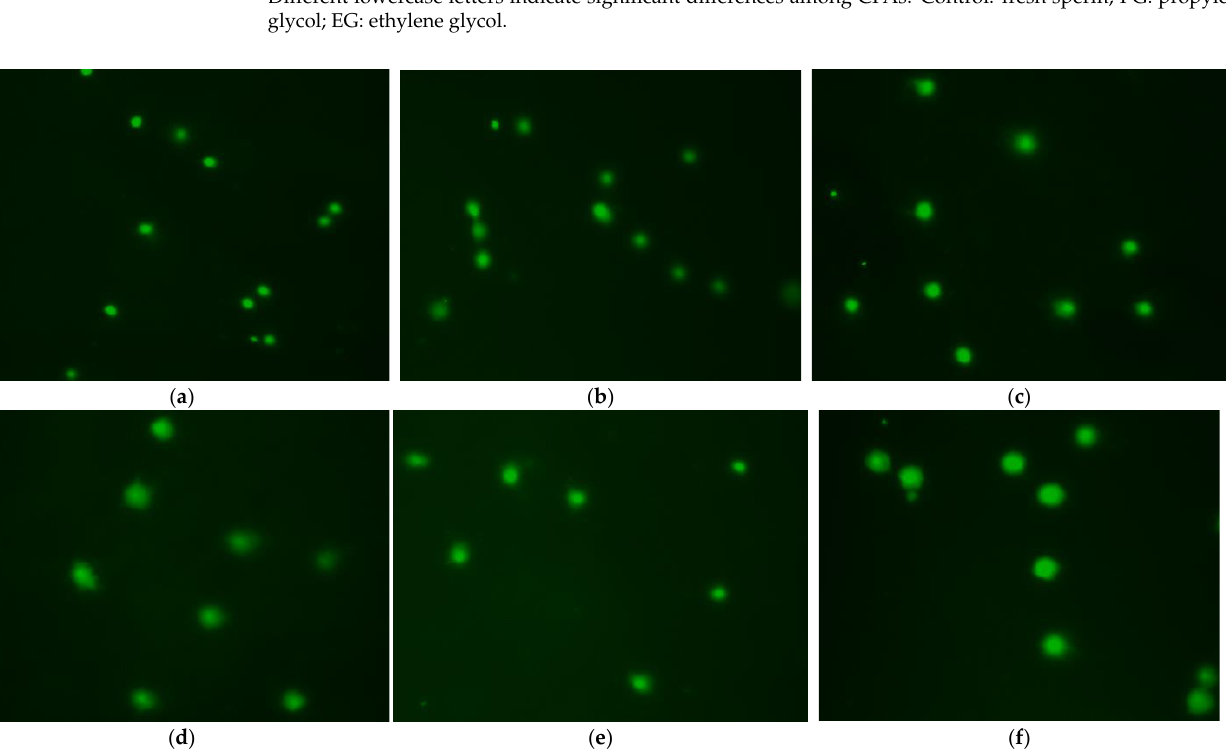
Figure 6. Fluorescent images of frozen and fresh sperm from roughscale sole, Clidoderma asperrimum , using various cryoprotective agents with 300 mM sucrose after comet assay. Each comet represents the damage level of DNA in sperm. ( a ) Fresh sperm, ( b ) Cryopreserved sperm using 10% DMSO, ( c ). Cryopreserved sperm using 10% propylene glycol, ( d ) Cryopreserved sperm using 10% ethylene glycol, ( e ) Cryopreserved sperm using 10% Methanol ( f ) Cryopreserved sperm using 10% Glycerol. In contrast, glycerol and methanol produced greater tail length, tail intensity, and tail migration. The impacts of diluent on cryopreservation-induced damage were studied using 10% DMSO as the CPA. Treatment with Stein’s solution produced low tail intensity, tail length, percentage of tail DNA, and tail migration values compared with other treatments, but these values were higher than values in the control group ( p < 0.05; Table 2). Figure 7 displayed images of the comet assay for this treatment group.